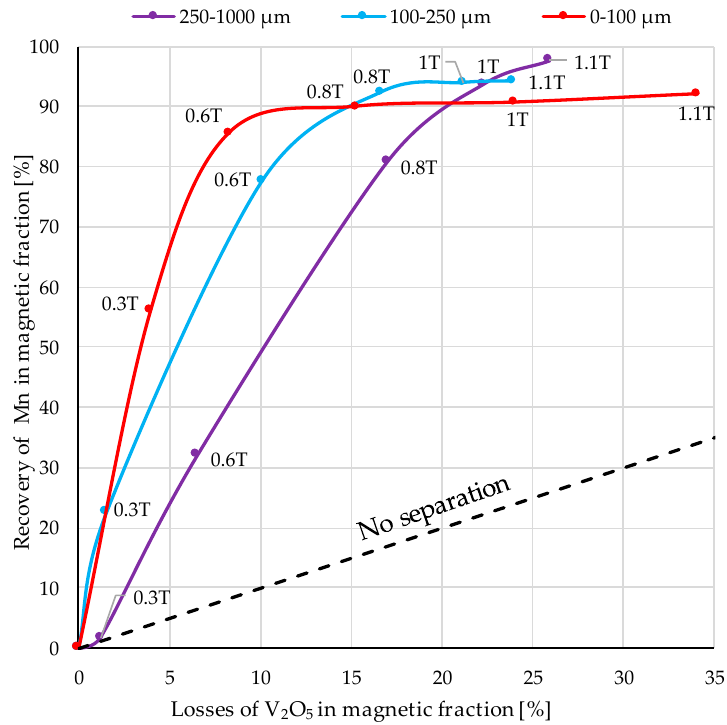
Figure 10. Losses of vanadium and recovery of manganese in magnetic fraction.